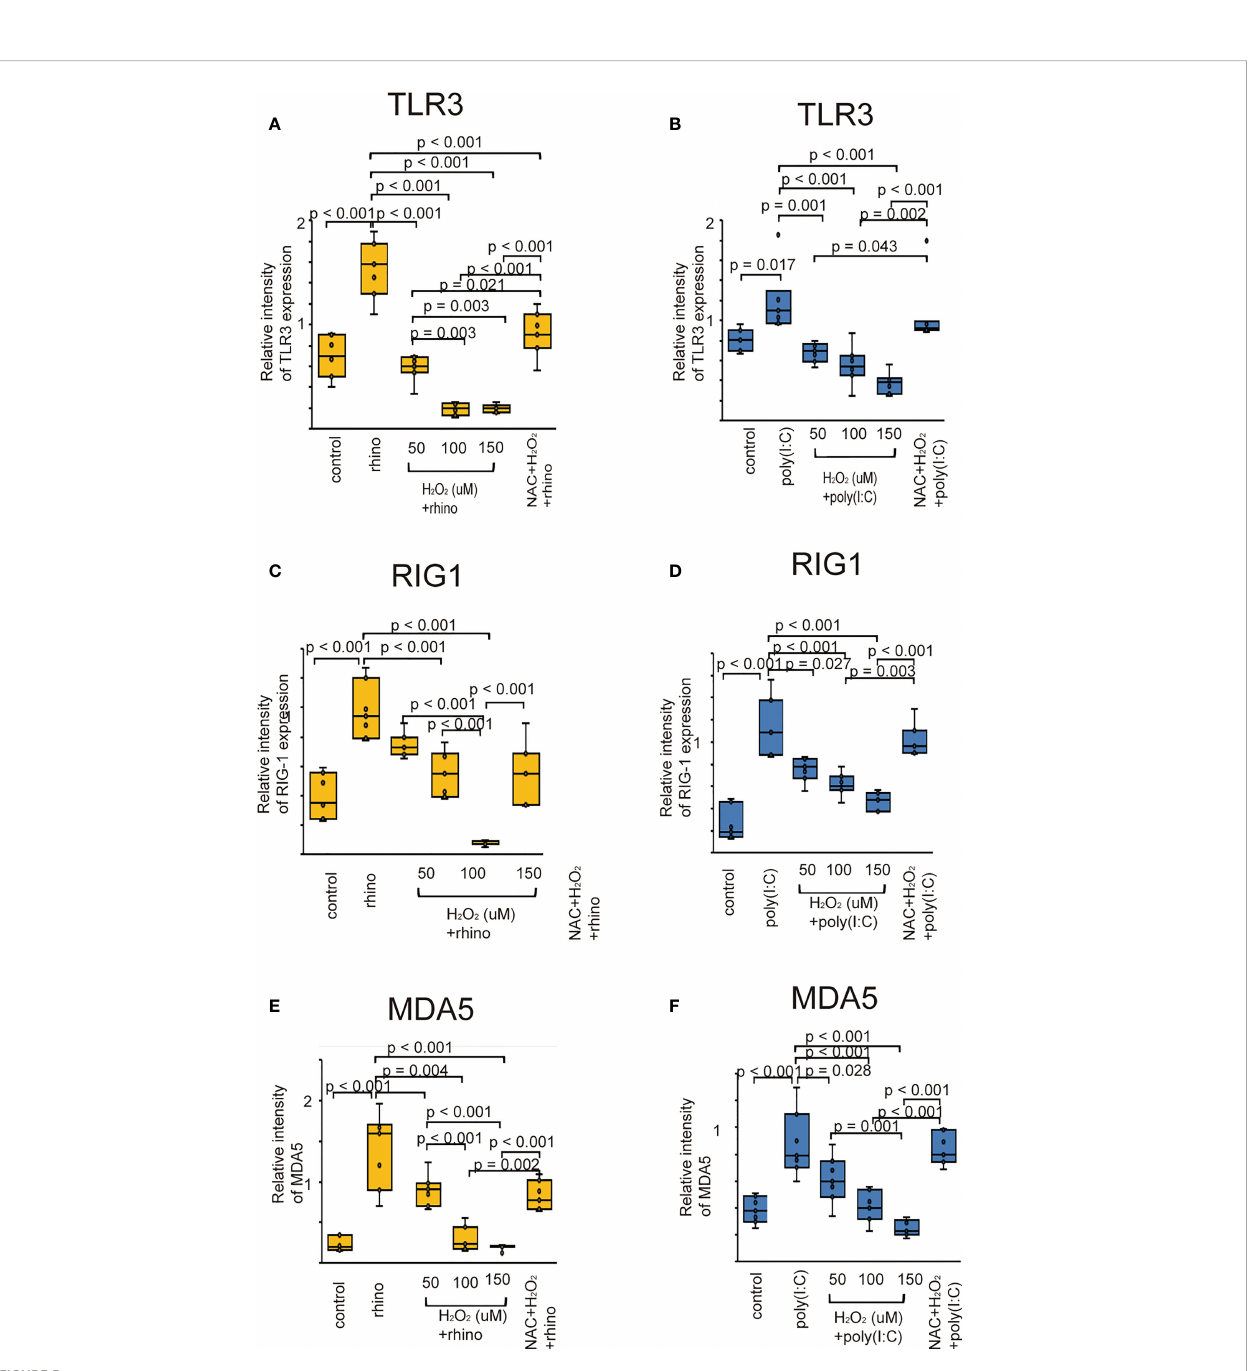
oxidative stress attenuates the expression of TLR3, RIG-1, and MDA5. Their protein levels were elevated in epithelial cells infected with RV 16 or stimulated with poly (I: C) (Figure 5). However, their upregulation was attenuated by pretreatment with H 2 O 2 in a dose-